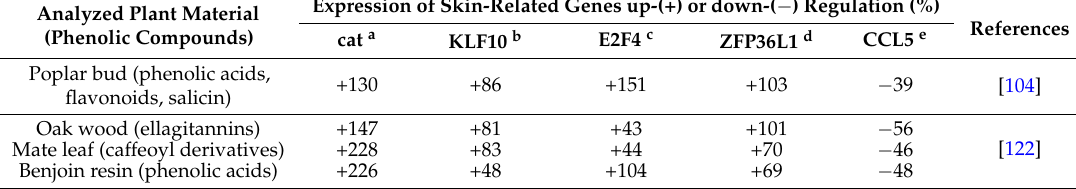
Table 2. The regulation of the skin-related genes expression in the normal human dermal fibroblasts (NHDF) cells treated with the extracts from black poplar buds, oak wood, mate leaves and benjoin resin. The results were referred to the control (untreated aged fibroblast cells, marked as 100%) [104,122]. Expression of Skin-Related Genes up-(+) or down-( ´ ) Regulation Analyzed Plant Material (Phenolic Compounds)